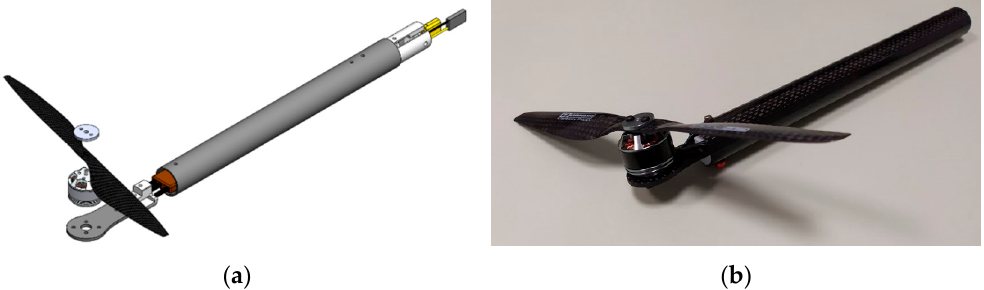
Figure 9. Rotor arm: ( a ) CAD assembly; ( b ) prototype assembly.